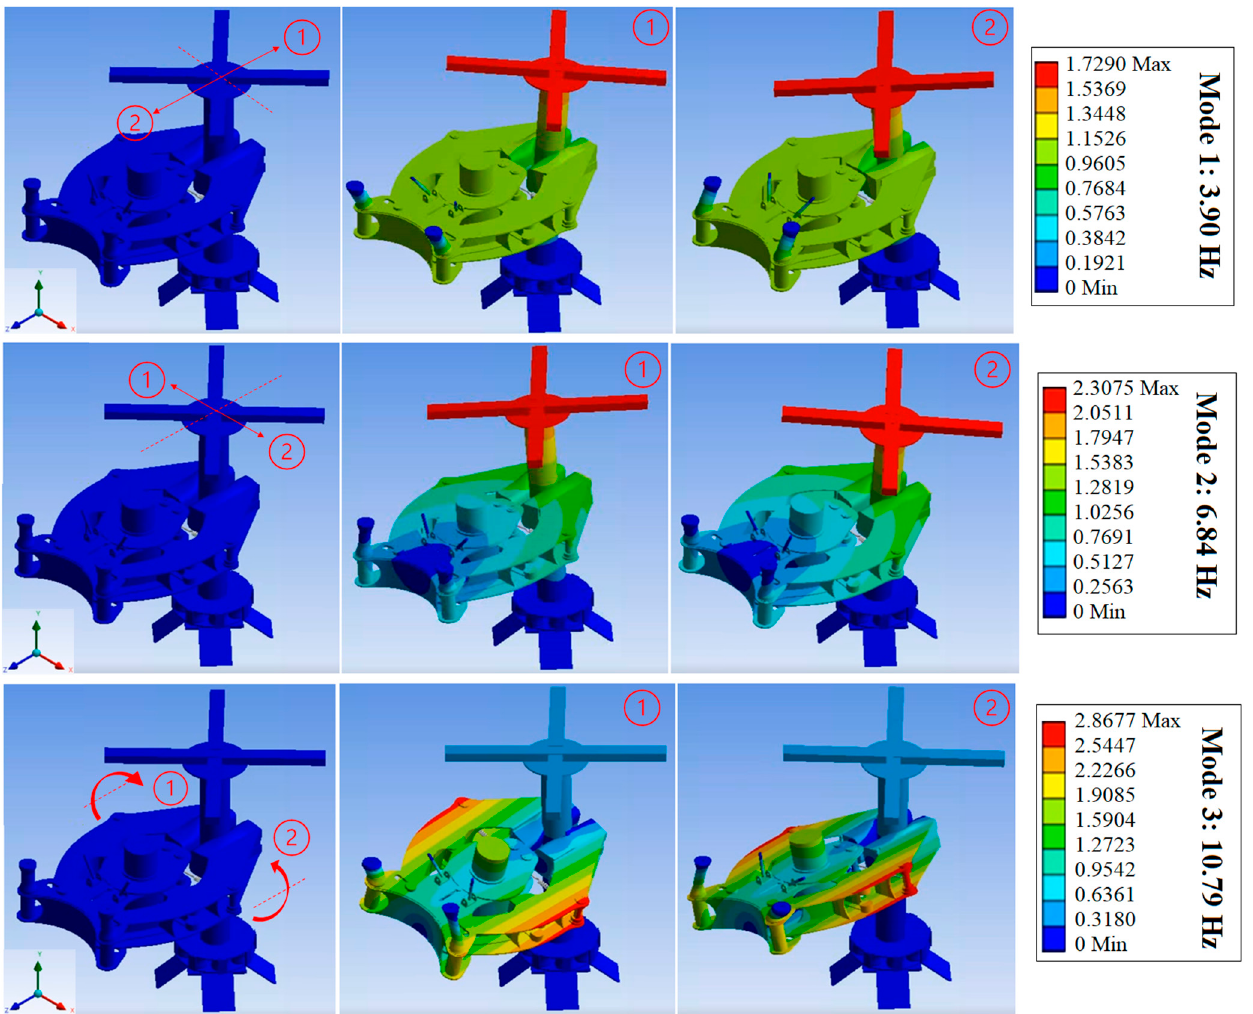
Figure 9. Deformations in mm calculated in the first 3 modes of the modal study. Positions 1 and 2 are the extremes in each mode.